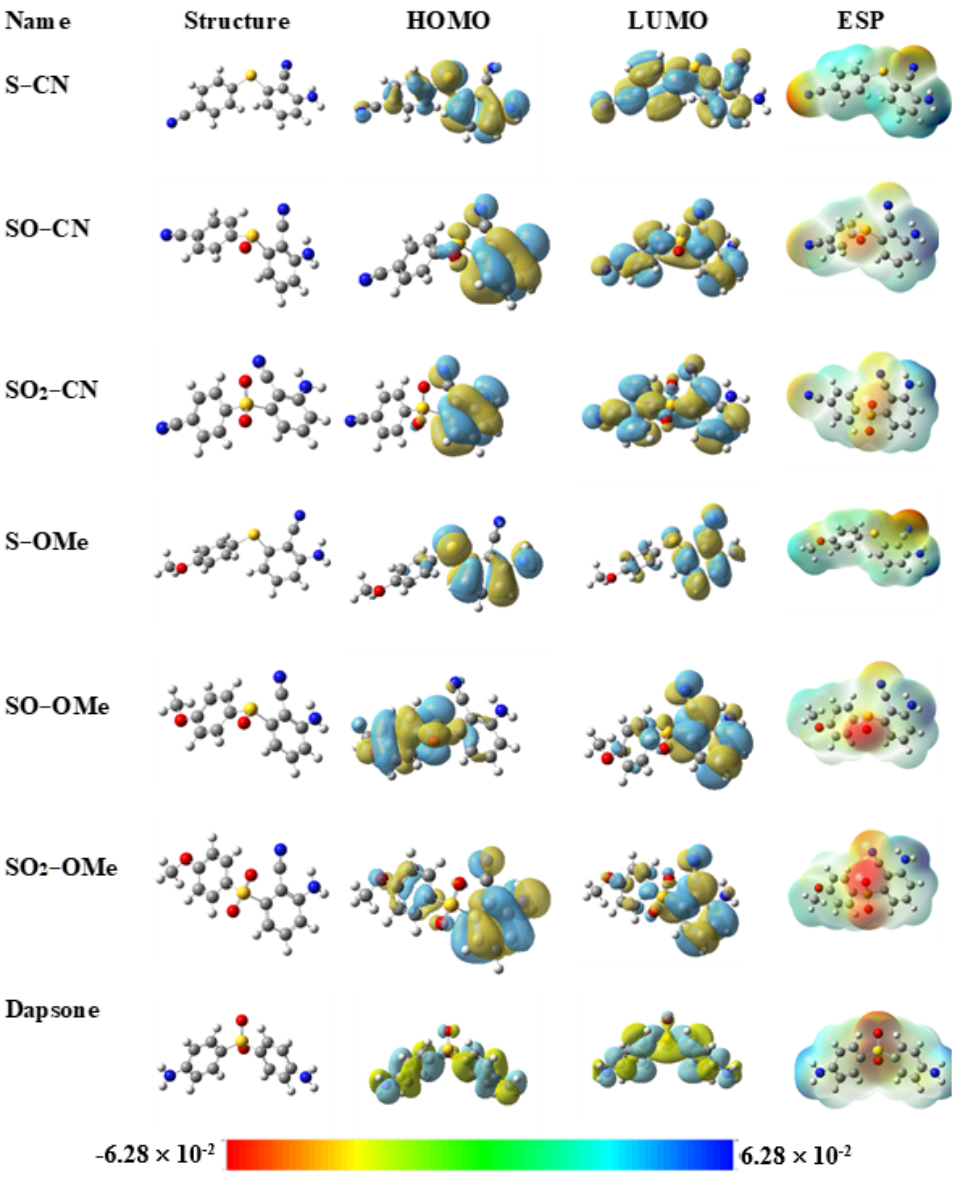
Figure 2. The geometry, frontier molecular orbital electron density distribution, and electrostatic potential map of the investigated molecules. The colored bar of MEP indicates the positive and negative potentials.